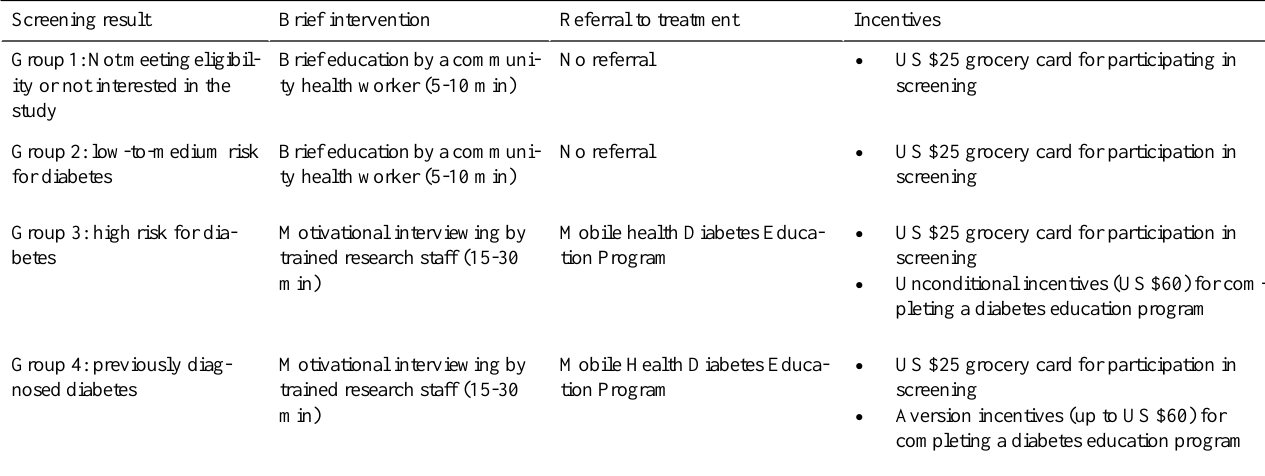
Table 1. Grouping of study participants and participant treatment.